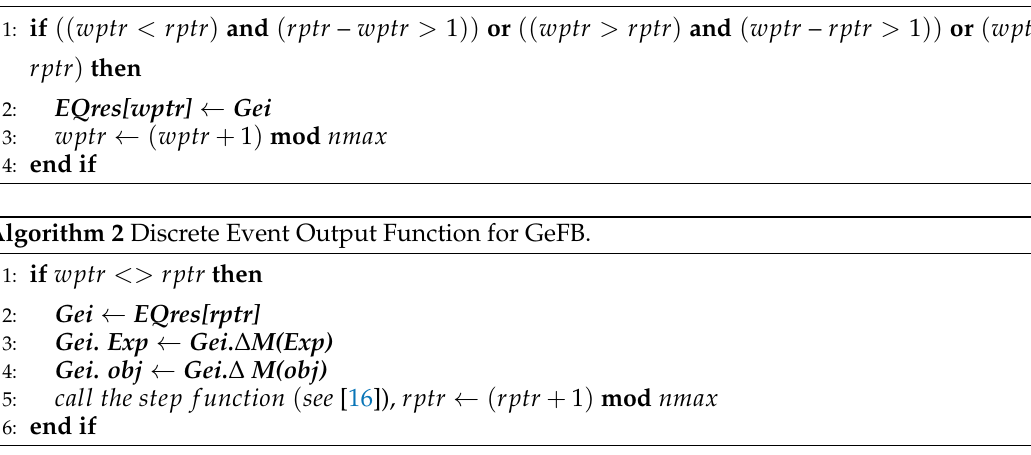
Algorithm 1 Discrete Event Input Function for GeFB.